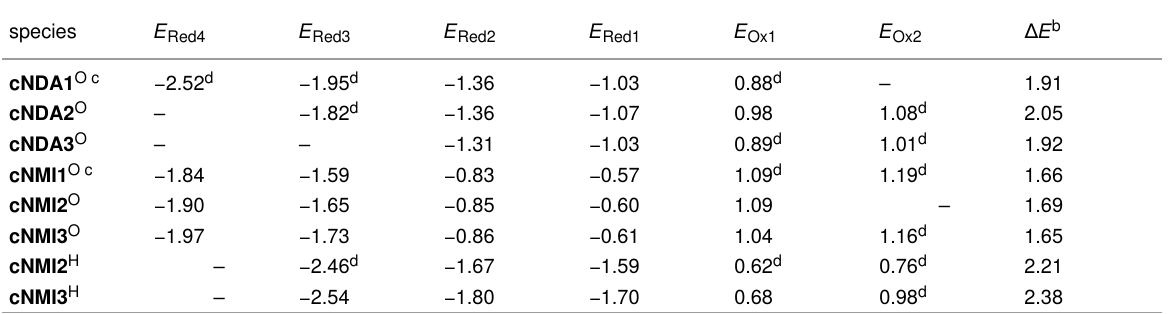
Table 3: Electrochemical data for the cNDA n O , cNMI n O and cNMI n H boomerangs derived from differential pulse voltammograms. a species E